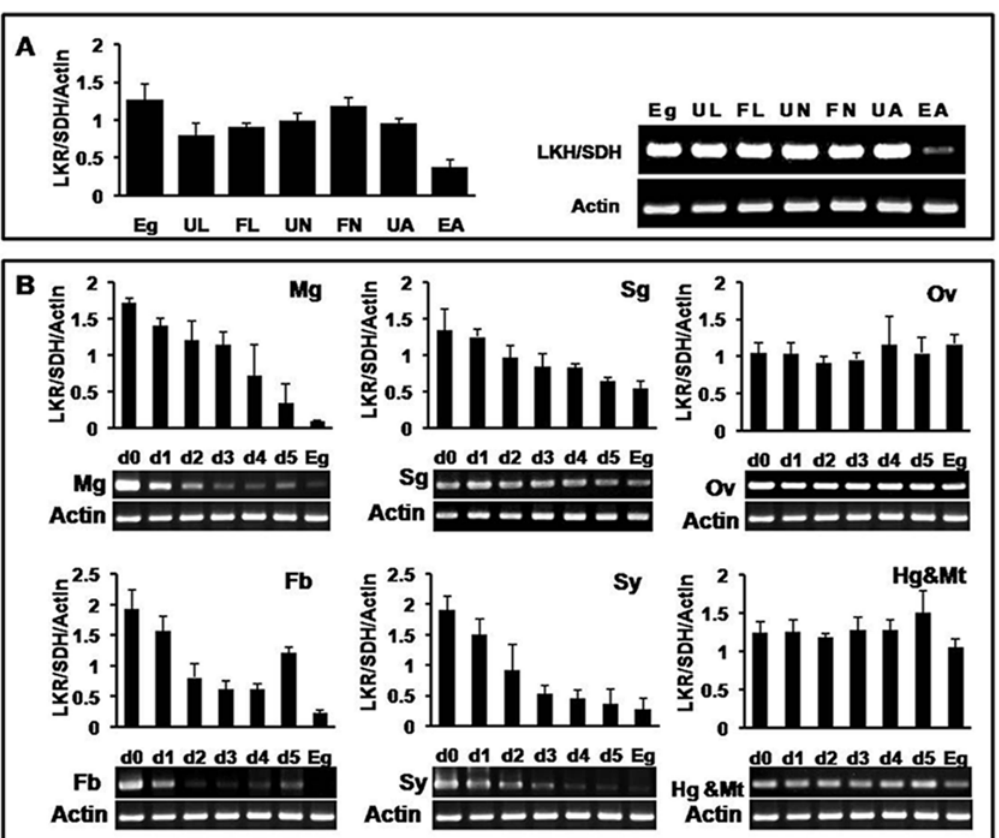
Figure 2. Transcription analysis of the LKR/SDH mRNA. The RT-PCR results shown are representative of 3 independent experiments with the same protocol. A, Stage-specific expression profiles of LKR/SDH shown by RT-PCR analyses. Lane 1, eggs; lane 2, unfed larvae; lane 3, fed larvae; lane 4, unfed nymphs; lane 5, fed nymphs; lane 6, unfed adult females, lane 7, engorged females of H. longicornis . RT-PCR was performed using LKR/SDH- specific primers and amplified 487-bp fragments. A 540 bp fragment of the constitutively expressed H. longicornis b - actin was amplified as an internal control. B, RT-PCR analysis of LKR/SDH mRNA expression in different tissues during blood feeding, Mg, midguts; Sg, salivary glands; Ov, ovaries; Fb, fat bodies; Sy, synganglions; Hg & Mt, hindguts with malphighian tubule. UF, unfed adult females; d1, females fed 1 day; d2, females fed 2 days; d3, females fed 3 days; d4, females fed 4 days, d5, females fed 5 days; Eg, engorged females. doi:10.1371/journal.pone.0007136.g002 in the midgut, ovary, fat body and synganglion of unfed ticks ( Figure 2B ).